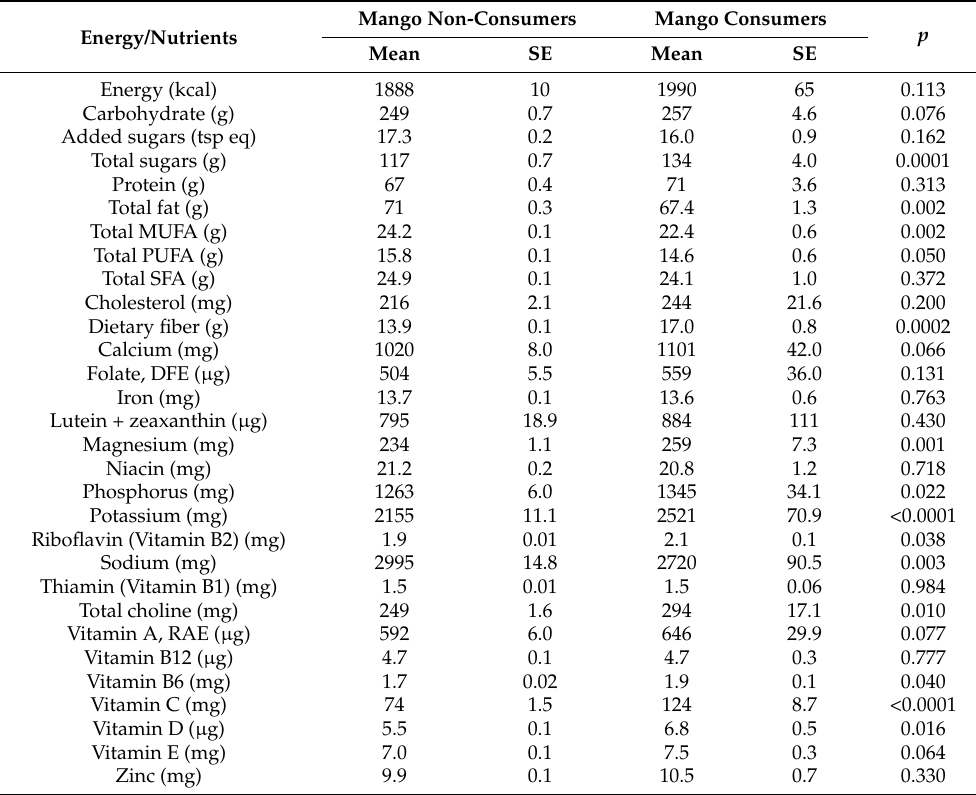
Table 2. Day 1 nutrient and energy intakes in mango non-consumers vs. mango consumers: children aged 2–18 years